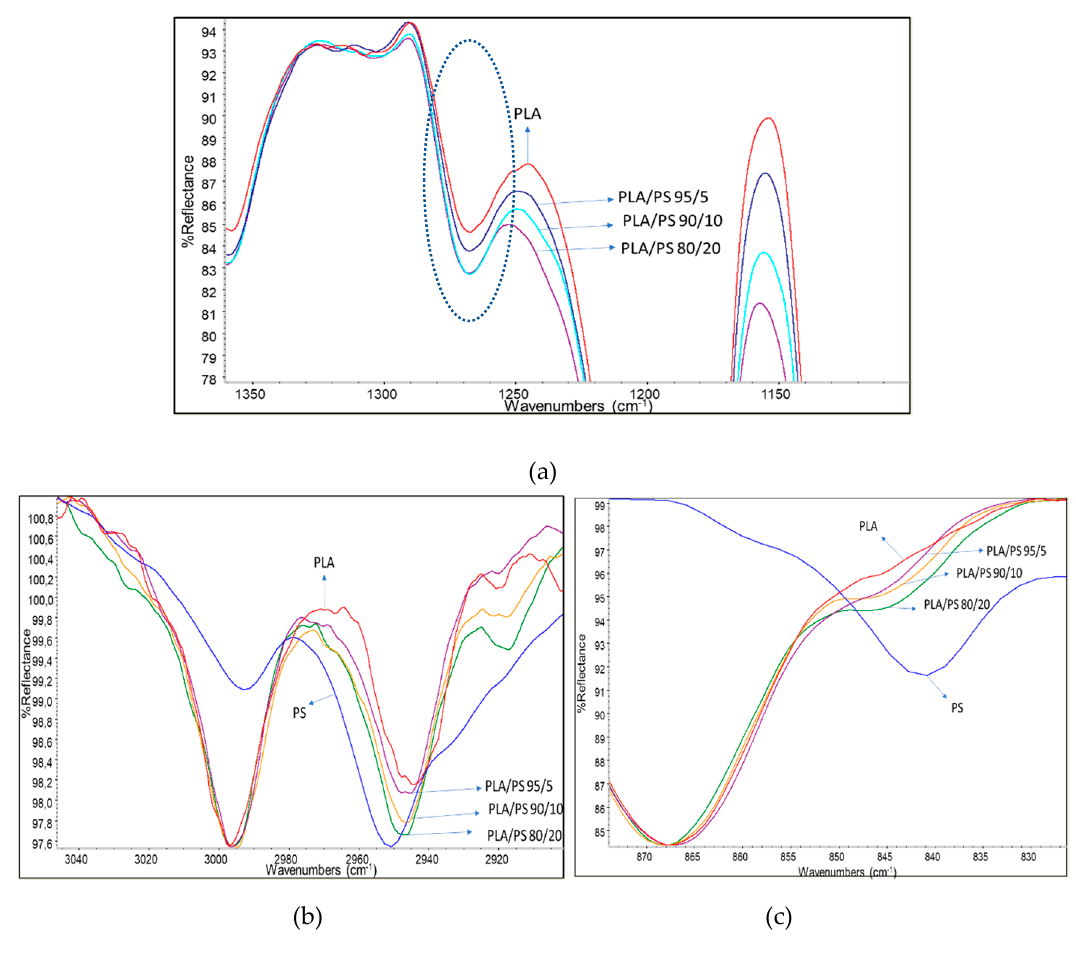
Figure 2. ( a ) zoom onto the amorphous band of PLA; ( b ) C-H stretching region of the spectra; ( c ) rocking CH 2 band (typical of poly(methyl methacrylate)—PMMA) region of the spectra. Spectra were slightly shifted on the vertical direction for normalizing with respect to reference bands, so the reflectance intensity is expressed in arbitrary units.